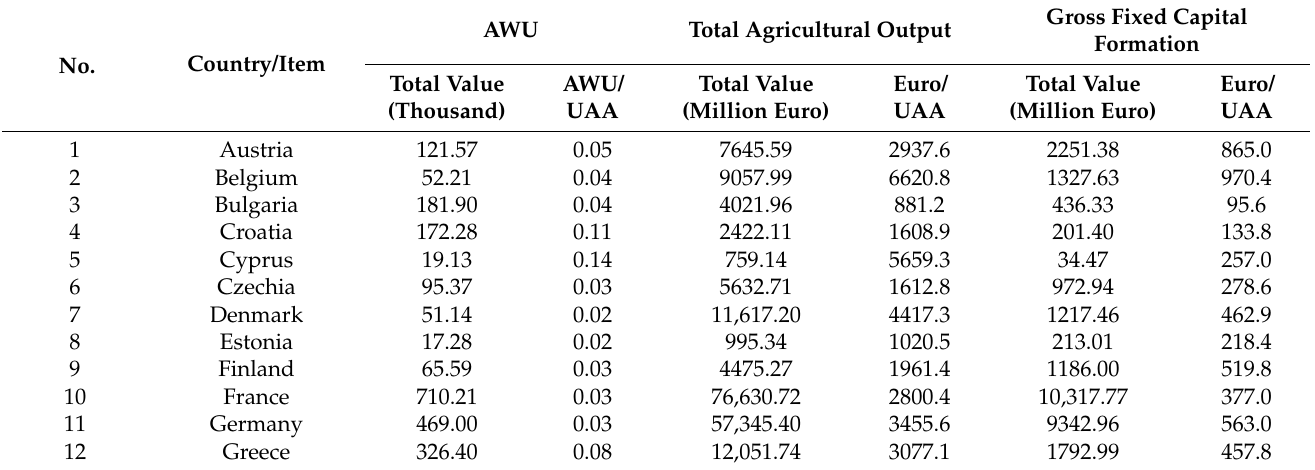
Table 8. The connection between agricultural labor, total agricultural output, and GFGF-EU,